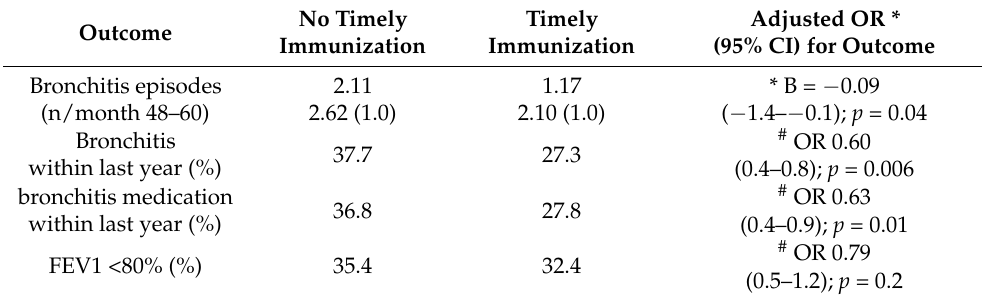
Table 3. Timely immunization is protective for bronchitis risk at 5 years.